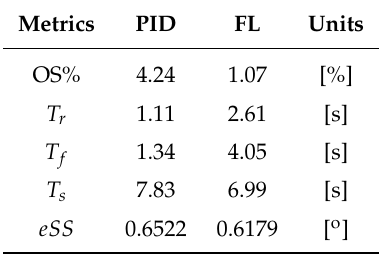
Table 4. Yaw Time Response Results in Underwater Experiments for PID and FL